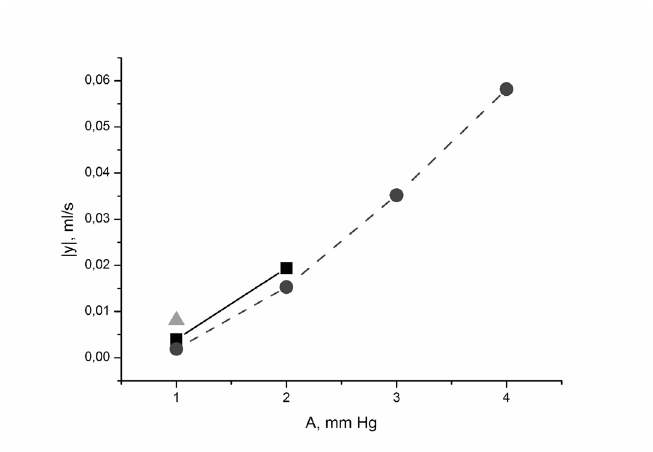
Figure 1. The graph of the lymphatic system: (i) — head, (ii) — neck, (iii) — diaphragm, (iv) — Figure 2. Results of calculations with natural gravity force influence with di ff erent characteristic pres- elbows, (v) — groin; 1 — thoracic duct, 2 — right lymphatic duct, 3 — cisterna chyli, 4 — subclavian sures (in the interstitial space and upper vena cava, zero pressure gradient) and amplitudes of contrac- trunks, 5 — lumbar trunks, 6 — lymph nodes. tions. A — amplitude of contractions, characteristic pressure is 5 mm Hg, circles — 10 mm Hg, triangles — 3 mm